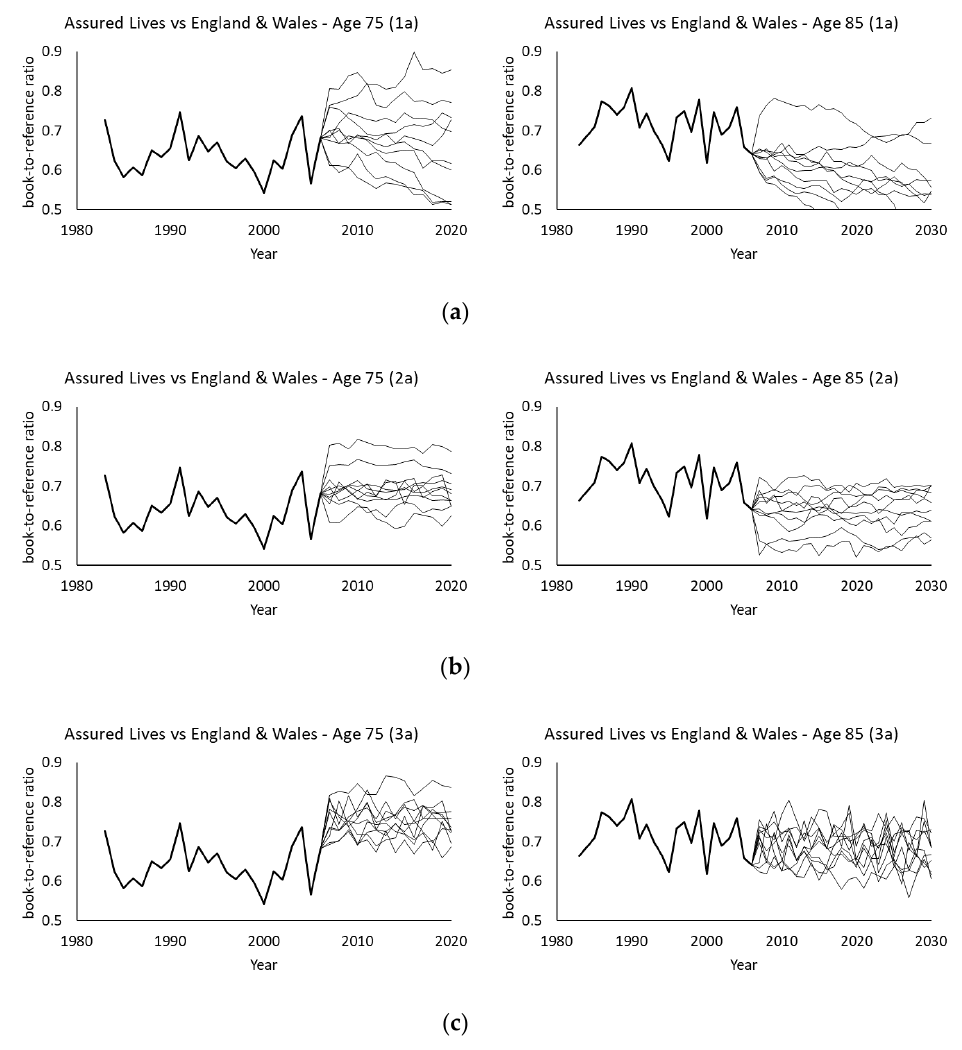
Figure 7. Simulated (and observed) book-to-reference ratios of central death rates at ages 75 and 85 from semi-parametric bootstrapping using assured lives (book) data and England and Wales (reference) data. ( a ) Model (1a); ( b ) Model (2a); ( c ) Model (3a). Table 4. Standard deviation and 99.5% VaR (minus mean) of pension plan liability (in % of mean). Model Choice Assured Lives Pensioners NZ TAI SG Monte Carlo